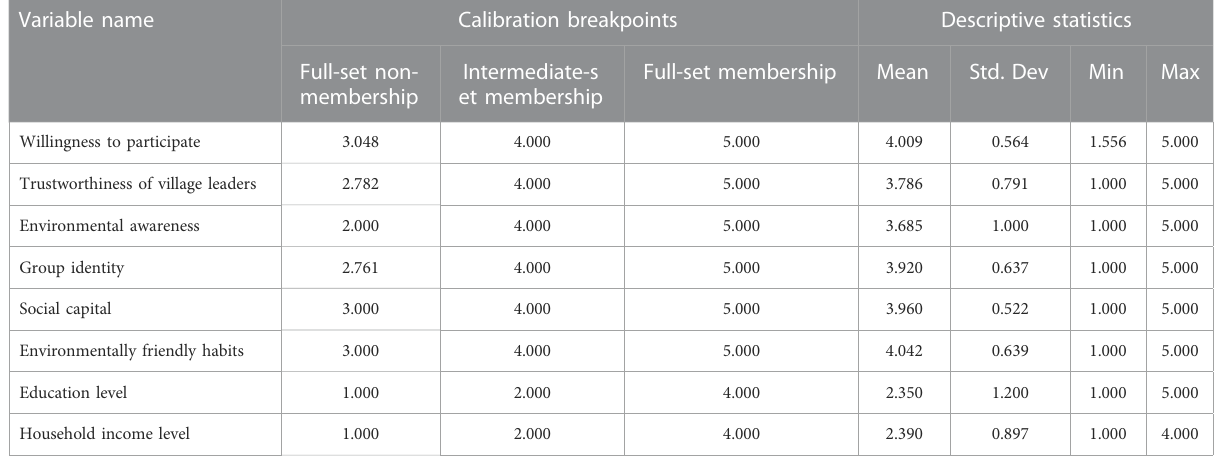
TABLE 2 Calibration results and descriptive statistical characteristics of conditional and outcome variables.